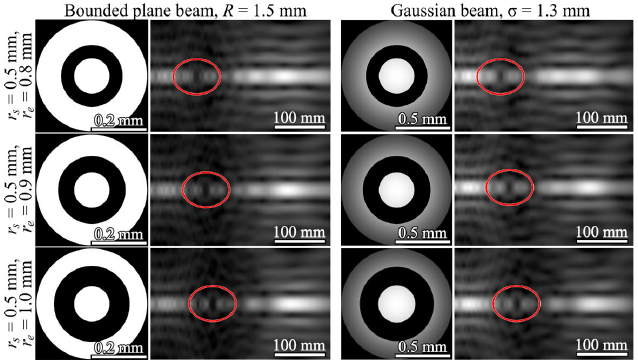
and the Gaussian beam.